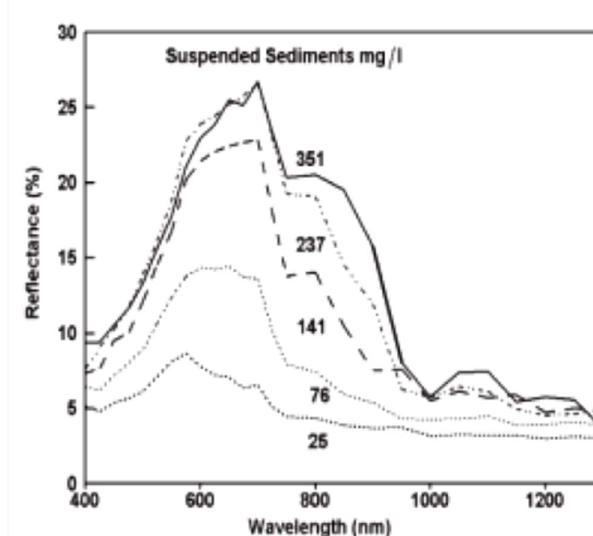
Figure 1. The relationship between reflectance and wavelength as affected by the concentration of suspended sediments (Ritchie et al., 1976).